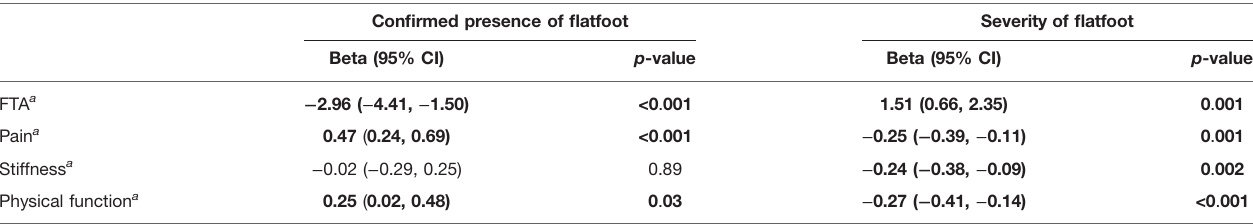
TABLE 5 | Regression analyses on the risk of FTA, pain, stiffness and physical function according to the presence of fl atfoot and the severity of fl atfoot.